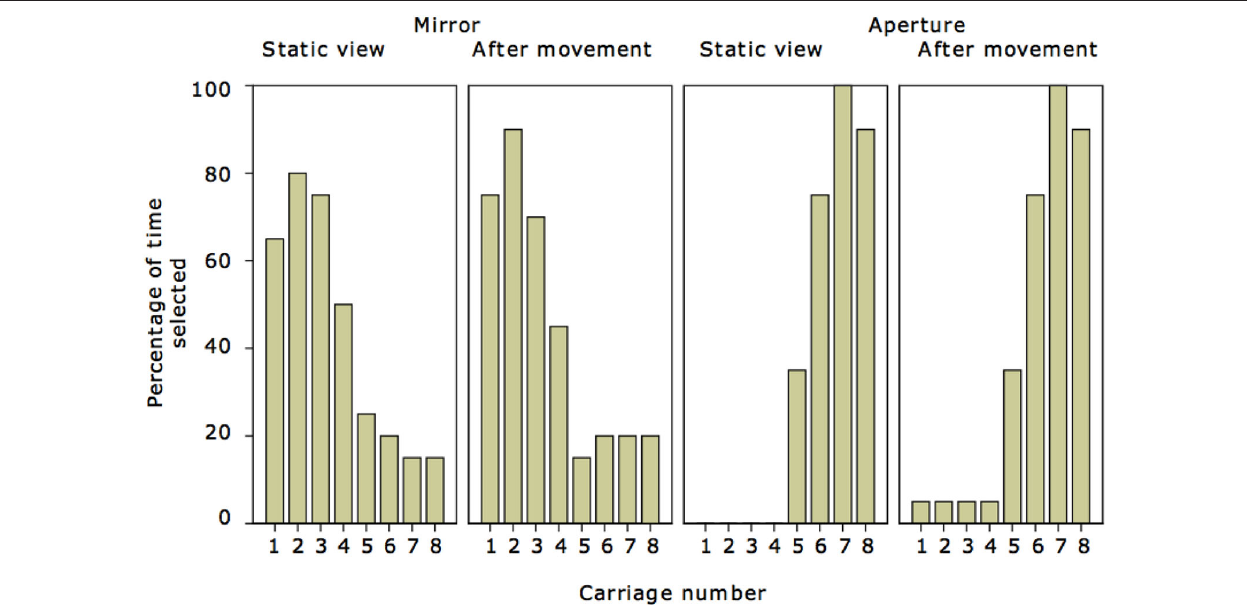
FIGURE 3 | For each of the four conditions the graphs show the number of times that each carriage was selected, as a percentage . As there were 20 participants in each condition 100% means that that carriage was selected 20 times.